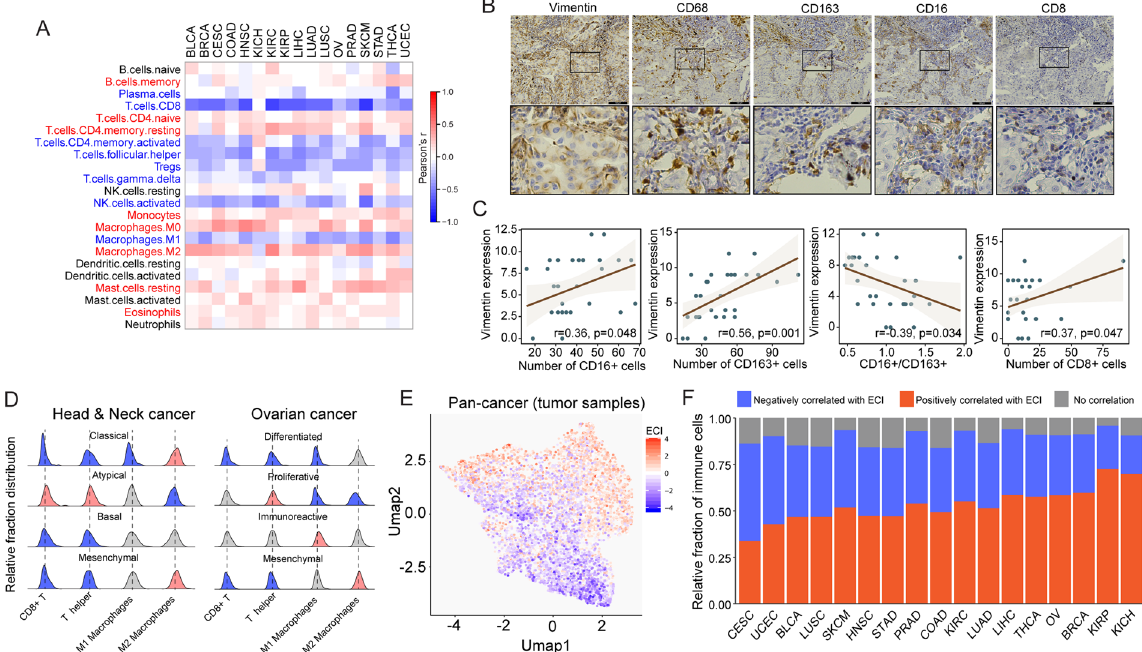
Fig. 4 Association of the cellular composition of immune in fi ltrates with EMT and immune evasion interactions. A Correlation between ECI and the in fi ltration of 22 immune cell subpopulations across 17 types of solid cancer. B Immunohistochemistry assay was performed to mark macrophages or CTLs and detect the expression of Vimentin in lung cancer. C Pearson correlation analysis was used to assess the correlation between Vimentin expression and macrophages or CTLs in fi ltration. D Distribution of relative in fi ltration fraction of CD8 + T, T helper cells, M1 and M2 macrophages cells in different cancer subtypes of ovarian cancer and head and neck squamous cell carcinoma. E Unsupervised cluster of pan-cancer tumor samples using uniform manifold approximation and projection based on the relative in fi ltration fraction of the 22 immune cell subpopulations. F Relative fraction of in fi ltrating immune cells positively or negatively correlated with ECI across the 17 types of solid cancer. Tumors are ordered by the ratio of in fi ltrating immune cells negatively correlated with ECI (blue color) vs. in fi ltrating immune cells positively correlated with ECI (red color). ECI EMT-CYT index, EMT epithelial-mesenchymal